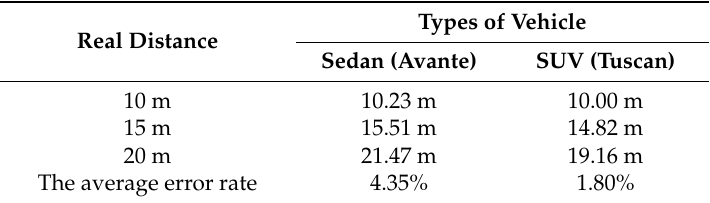
Table 3. The result of following distance